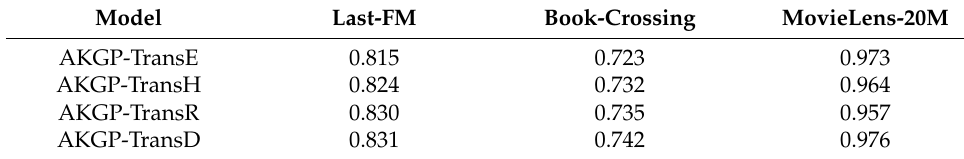
Table 5. Influence of different representation learning methods on AUC. Model Last-FM